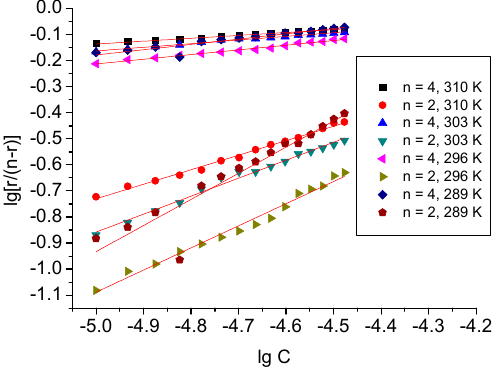
Figure 2. Sips plots of IVIG binding to 7-ethylcamptothecin at pH 4.0 and different temperatures. Table 1. Parameters of IVIG binding to six CPTs at pH 4.0 and different temperatures [43–45]. Temperature K